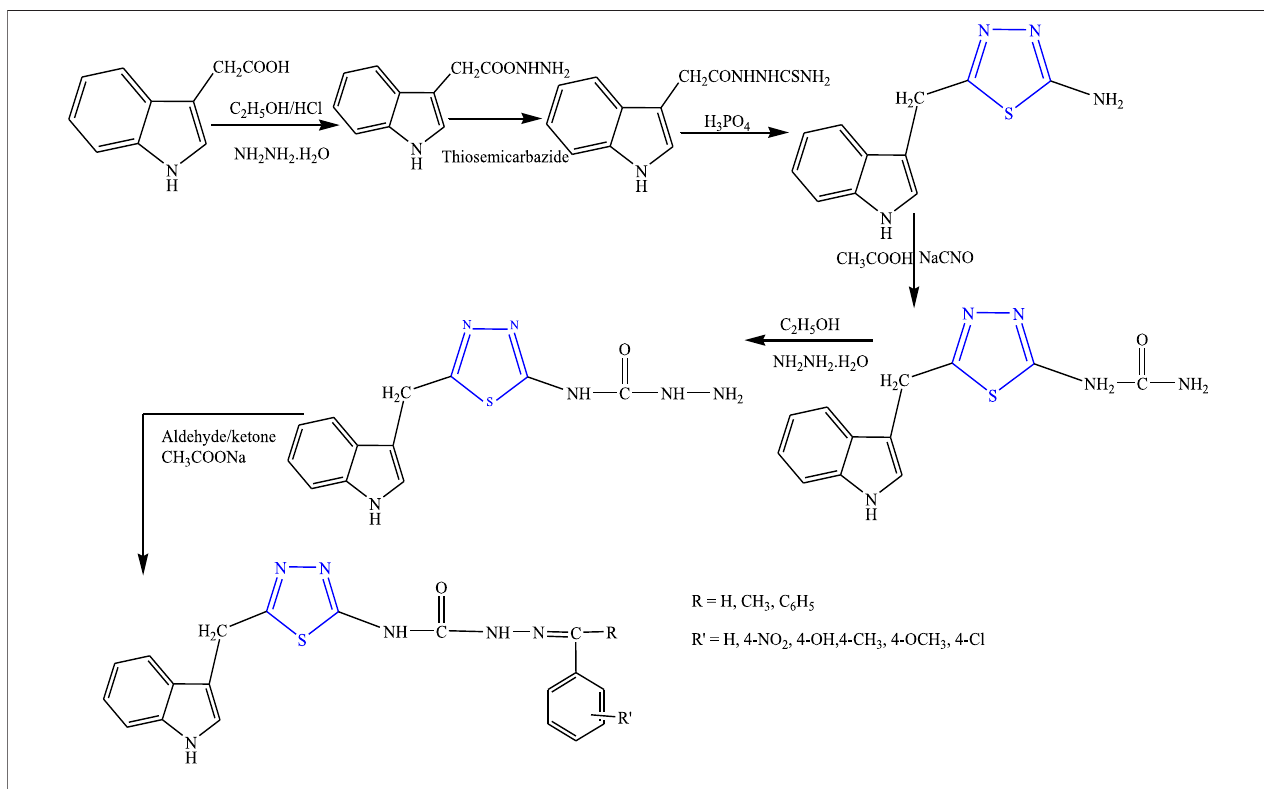
FIGURE 23 | Synthetic pathway for designing 1,3,4-thiadiazoles